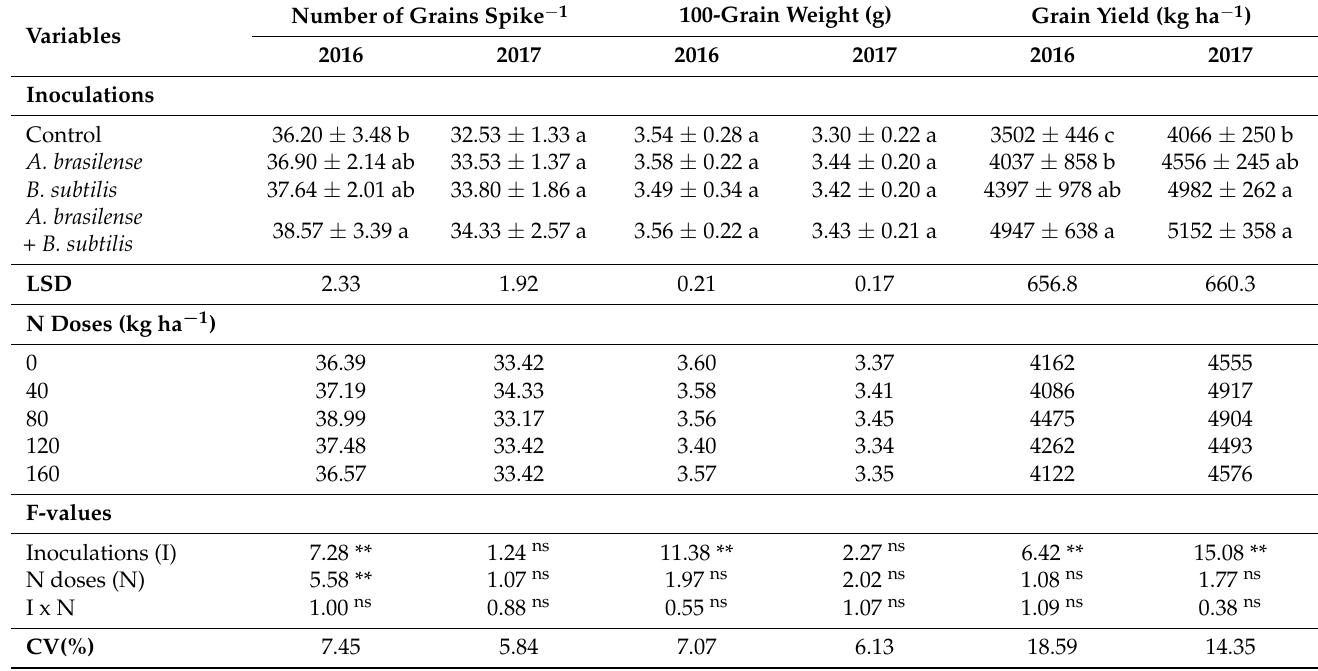
Table 4. Number of grains spike − 1 , 100-grain weight and grain yield of wheat as a function of inoculation with growth-promoting bacteria and N doses in 2016 and